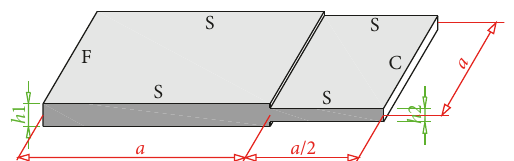
Figure 6: Geometry and boundary conditions of the isotropic stepped plate.